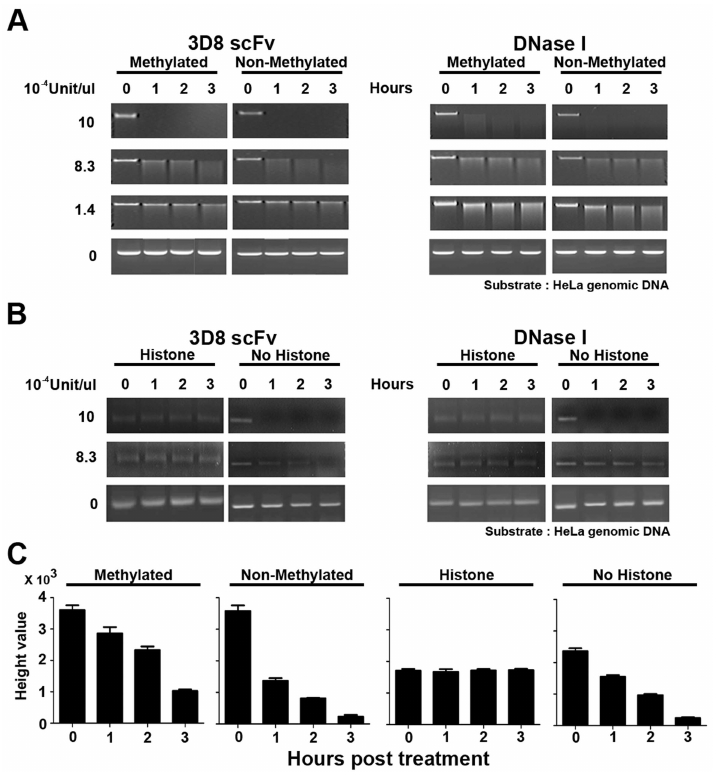
Figure 6. 3D8 scFv cannot hydrolyze methylated DNA or protein-bound DNA. A . HeLa methylated genomic DNA and non-methylated DNA (NEB) were treated with 3D8 scFv and DNase I at four concentrations: 10 6 10 2 4 U/ m l, 8.3 6 10 2 4 U/ m l, 1.4 6 10 2 4 U/ m l, and 0 U/ m l. The DNA samples were harvested and analyzed by electrophoresis at 0, 1, 2, and 3 hr after treatment. At a concentration of 8.3 6 10 2 4 U/ m l, 3D8 scFv digested more non-methylated DNA than DNase I 1 hr after treatment. B . Chromatin was prepared using the EZ-Zyme Enzymatic Chromatin Prep kit. Prepared chromatin DNA and naked DNA were treated with 3D8 scFv and DNase I (10 6 10 2 4 U, 8.3 6 10 2 4 U, and 0 U/ m l). The DNA samples were harvested and analyzed by electrophoresis at 0, 1, 2, and 3 hr after treatment. Neither 3D8 scFv nor DNase I hydrolyzed histone-bound DNA at concentrations of 10 6 10 2 4 U/ m l and 8.3 6 10 2 4 U/ m l. When naked DNA was treated with 3D8 scFv at concentrations of 8.3 6 10 2 4 U/ m l, 3D8 scFv could digest naked DNA. But, DNase I could not digest naked DNA at 8.3 6 10 2 4 U/ m l. C . The relative quantitative values of each DNA of methylated, non-methylated, histone-bound, and naked HeLa genomic DNA were measured for 3 hr after each DNA was treated with 3D8 scFv (8.3 6 10 2 4 U/ m l). The bar graphs indicate the average values of each sample calculated from three individual